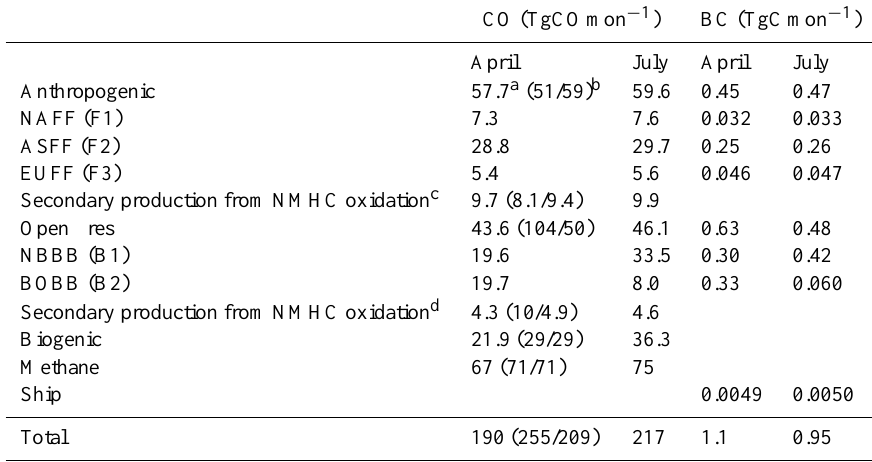
Table 2. Global and regional emissions of CO and BC in April and July